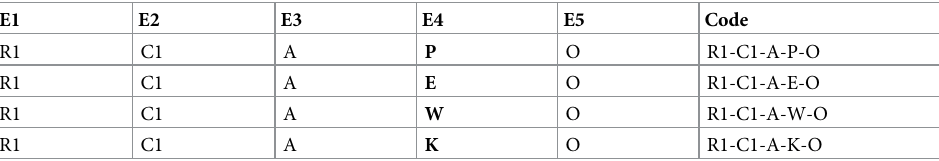
Table 11. Changing one element results in phenotype permutations in single-rooted